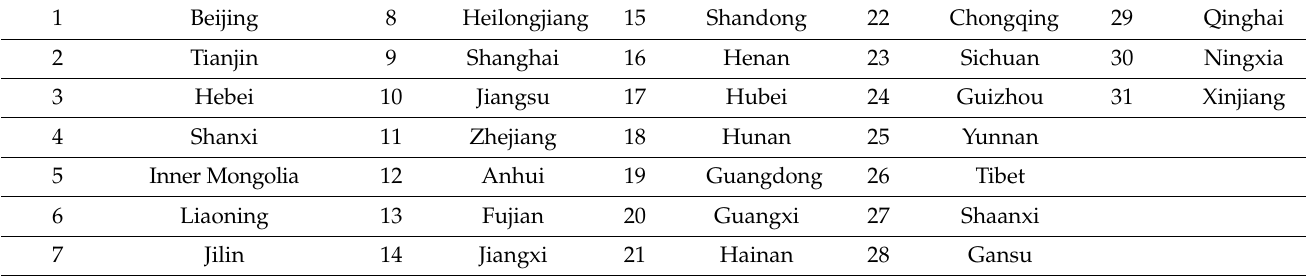
Figure 8. Moran scatter plot of the coordination index (CID) in 2009 (above) and 2019 (below). Table 7. Provinces and cities code table.